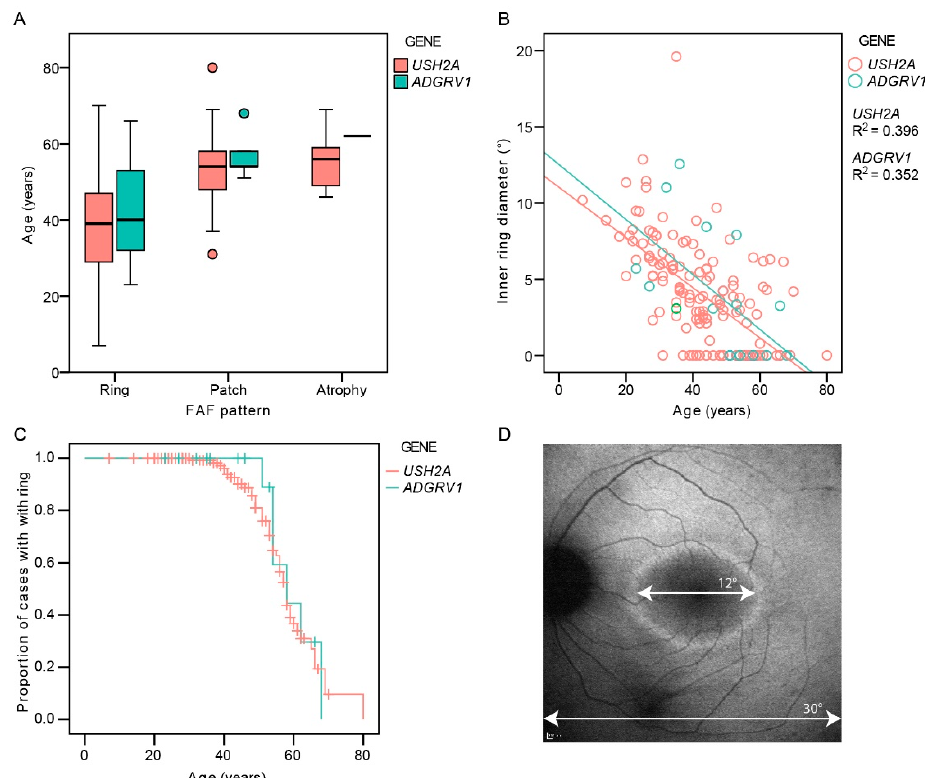
Figure 4. ( A ). Boxplot showing ages of patients with different autofluorescence patterns. ( B ). The diameter of the hyperautofluorescent ring in relation to age and genotype. ( C ). Kaplan–Meier survival analysis showing the proportion of cases with FAF pattern of hyperautofluorescent ring (preserved central retina) with increasing age. ( D ). Demonstration of the measurement of the inner ring diameter. Note the similarity between the survival curves representing the structural ( C ) and functional decline (Figure 2). Red color represents USH2A patients and green color represents ADGRV1 patients.